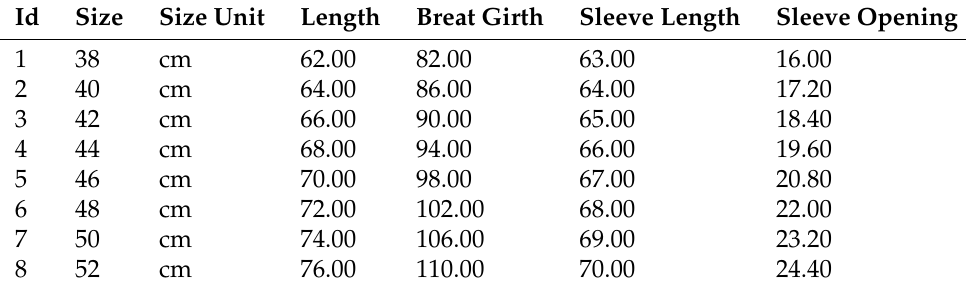
Table 7. Standard men’s shirt size chart.